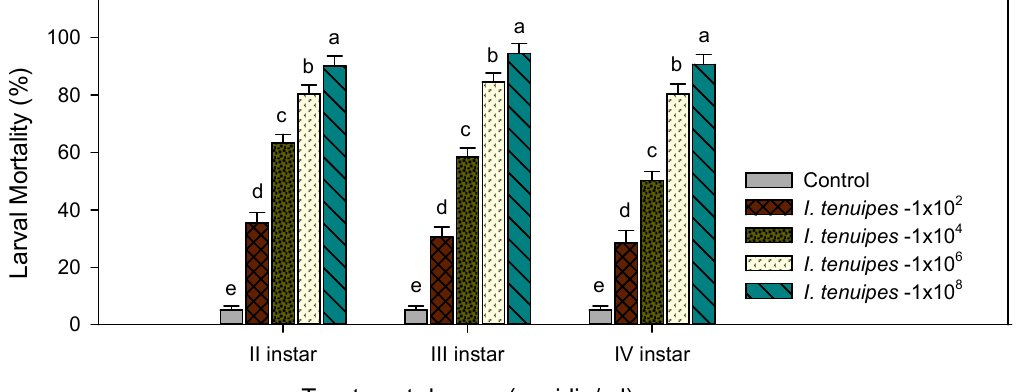
Figure 1. Percentage mortality of second, third and fourth instar larvae of Ae. aegypti after treatment with Isaria tenuipes conidial spores (My-It). Means (± SE) followed by the same letters above bars indicate no significant difference ( p ≤ 0.05) using Probit analysis. The different letters (a-e) indicate significant differences between the control and treatments.